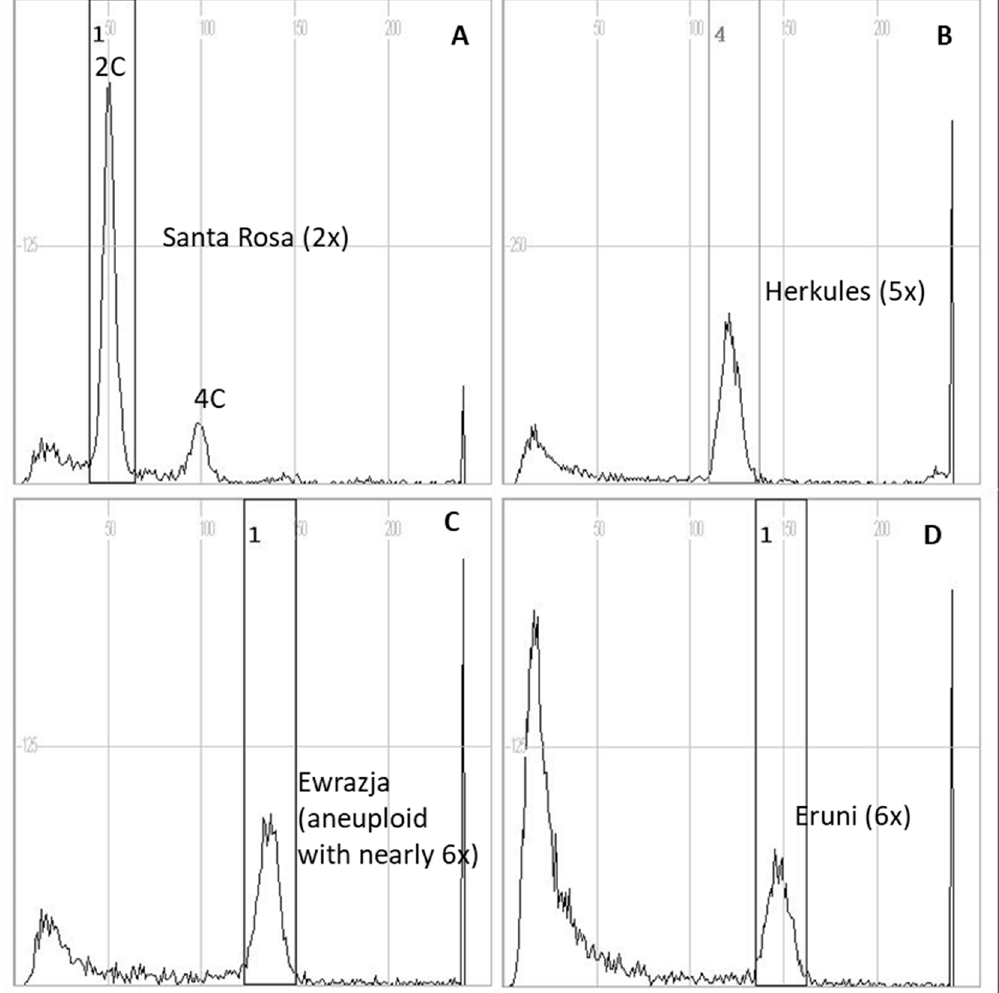
Figure 1. Histograms of ploidy level estimation of Japanese plum cultivars using flow cytometry (FCM): ( A ) external standard diploid cultivar ‘Santa Rosa’; ( B ) pentaploid ‘Herkules’; and, ( C ) aneuploid showing nearly hexaploidy ‘Yevrazija’, and ( D ) reference hexaploid ‘Eruni’.